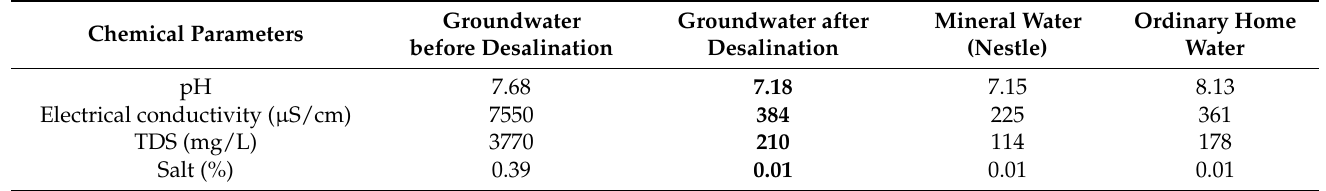
Table 1. Comparison of groundwater (before and after desalination): physical–chemical parameters. Groundwater Chemical Parameters before